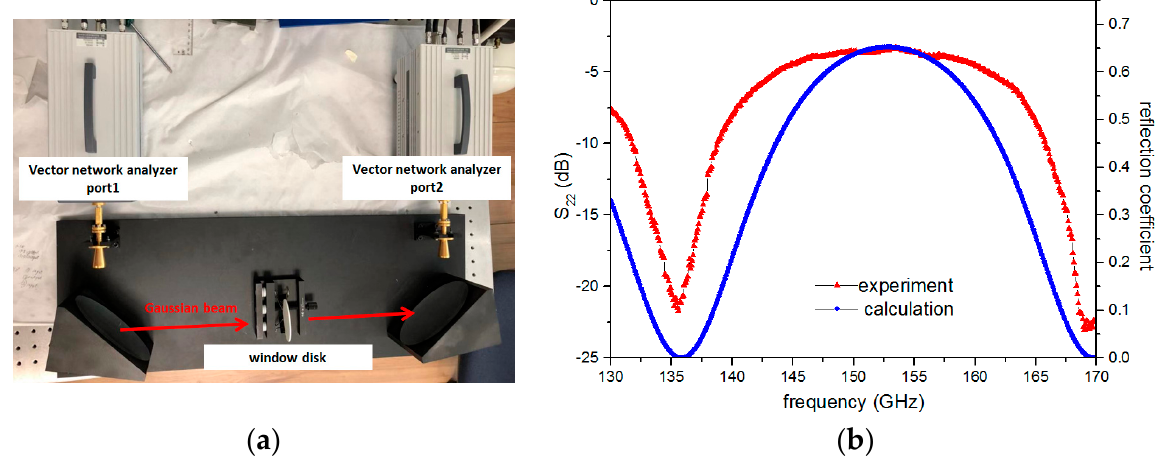
Figure 13. Measurement system and result of window measurement: ( a ) measurement system of window; ( b ) experimentally measured and calculated reflection coefficients of sapphire window.